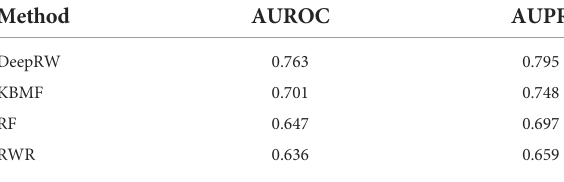
TABLE 3 The AUROC and AUPR scores of different methods.